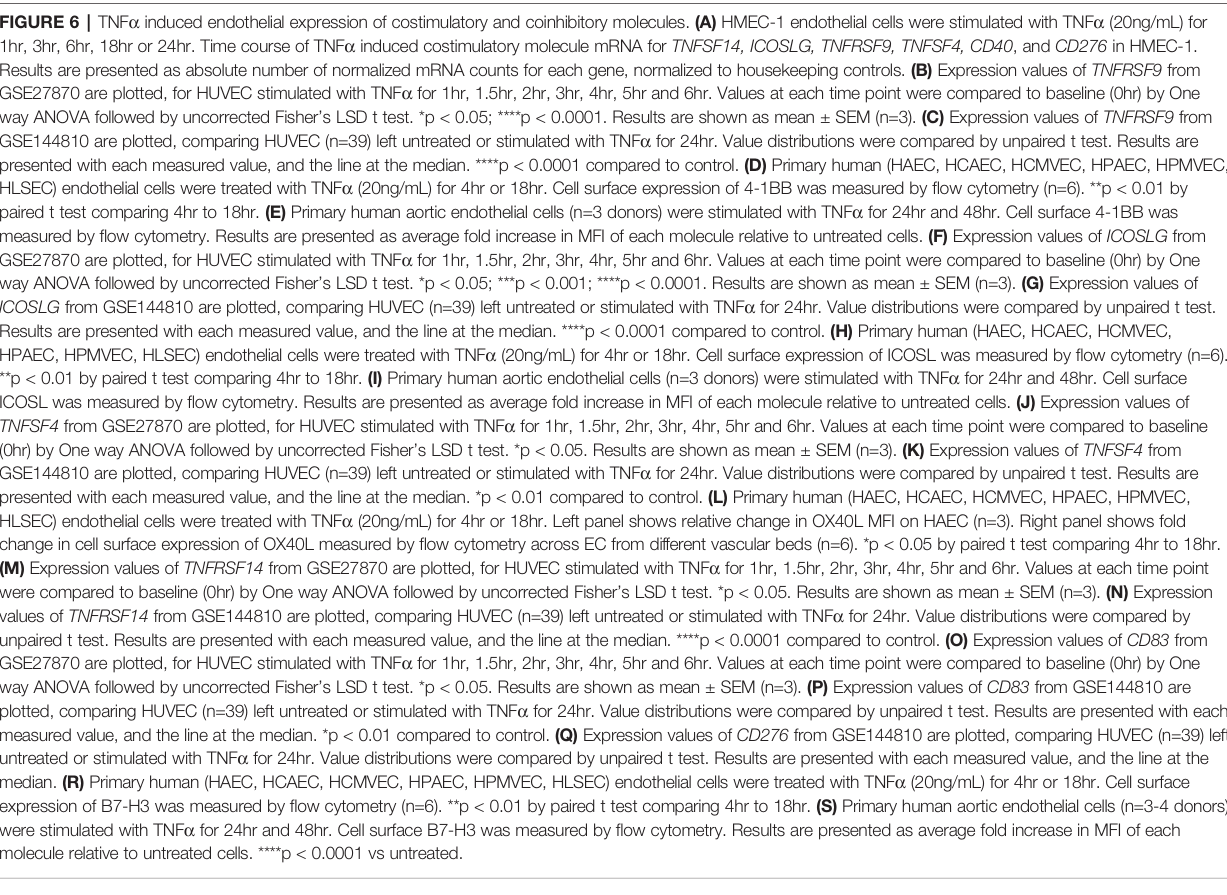
FIGURE 6 | TNF a induced endothelial expression of costimulatory and coinhibitory molecules. (A) HMEC-1 endothelial cells were stimulated with TNF a (20ng/mL) for 1hr, 3hr, 6hr, 18hr or 24hr. Time course of TNF a induced costimulatory molecule mRNA for TNFSF14, ICOSLG, TNFRSF9, TNFSF4, CD40 , and CD276 in HMEC-1. Results are presented as absolute number of normalized mRNA counts for each gene, normalized to housekeeping controls. (B) Expression values of TNFRSF9 from GSE27870 are plotted, for HUVEC stimulated with TNF a for 1hr, 1.5hr, 2hr, 3hr, 4hr, 5hr and 6hr. Values at each time point were compared to baseline (0hr) by One way ANOVA followed by uncorrected Fisher ’ s LSD t test. *p < 0.05; ****p < 0.0001. Results are shown as mean ± SEM (n=3). (C) Expression values of TNFRSF9 from GSE144810 are plotted, comparing HUVEC (n=39) left untreated or stimulated with TNF a for 24hr. Value distributions were compared by unpaired t test. Results are presented with each measured value, and the line at the median. ****p < 0.0001 compared to control. (D) Primary human (HAEC, HCAEC, HCMVEC, HPAEC, HPMVEC, HLSEC) endothelial cells were treated with TNF a (20ng/mL) for 4hr or 18hr. Cell surface expression of 4-1BB was measured by fl ow cytometry (n=6). **p < 0.01 by paired t test comparing 4hr to 18hr. (E) Primary human aortic endothelial cells (n=3 donors) were stimulated with TNF a for 24hr and 48hr. Cell surface 4-1BB was measured by fl ow cytometry. Results are presented as average fold increase in MFI of each molecule relative to untreated cells. (F) Expression values of ICOSLG from GSE27870 are plotted, for HUVEC stimulated with TNF a for 1hr, 1.5hr, 2hr, 3hr, 4hr, 5hr and 6hr. Values at each time point were compared to baseline (0hr) by One way ANOVA followed by uncorrected Fisher ’ s LSD t test. *p < 0.05; ***p < 0.001; ****p < 0.0001. Results are shown as mean ± SEM (n=3). (G) Expression values of ICOSLG from GSE144810 are plotted, comparing HUVEC (n=39) left untreated or stimulated with TNF a for 24hr. Value distributions were compared by unpaired t test. Results are presented with each measured value, and the line at the median. ****p < 0.0001 compared to control. (H) Primary human (HAEC, HCAEC, HCMVEC, HPAEC, HPMVEC, HLSEC) endothelial cells were treated with TNF a (20ng/mL) for 4hr or 18hr. Cell surface expression of ICOSL was measured by fl ow cytometry (n=6). **p < 0.01 by paired t test comparing 4hr to 18hr. (I) Primary human aortic endothelial cells (n=3 donors) were stimulated with TNF a for 24hr and 48hr. Cell surface ICOSL was measured by fl ow cytometry. Results are presented as average fold increase in MFI of each molecule relative to untreated cells. (J) Expression values of TNFSF4 from GSE27870 are plotted, for HUVEC stimulated with TNF a for 1hr, 1.5hr, 2hr, 3hr, 4hr, 5hr and 6hr. Values at each time point were compared to baseline (0hr) by One way ANOVA followed by uncorrected Fisher ’ s LSD t test. *p < 0.05. Results are shown as mean ± SEM (n=3). (K) Expression values of TNFSF4 from GSE144810 are plotted, comparing HUVEC (n=39) left untreated or stimulated with TNF a for 24hr. Value distributions were compared by unpaired t test. Results